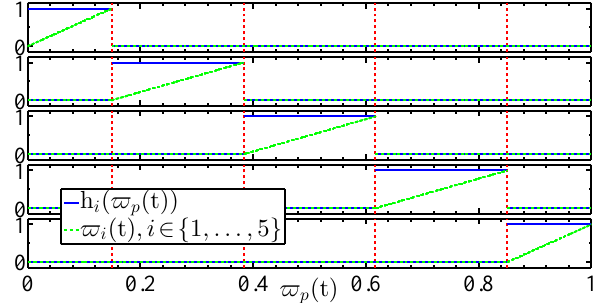
Figure 17: Commanded thrust forces and moment. Le- gend: Sg = Surge, Sw = Sway, Hv = Heave, and Yw =